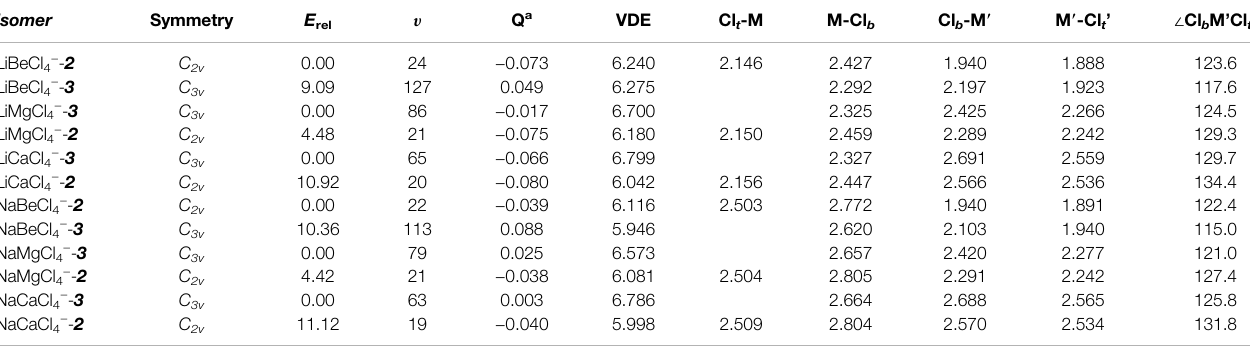
TABLE 1 | Relative energies E rel (kcal/mol), the lowest vibrational frequencies υ (cm − 1 ), total NBO charges on the MCl subunit (|e|), vertical detachment energies VDE (eV), bond lengths (Å), and select bond angles (degree) of the MM ′ Cl 4 − (M = Li, Na; M ′ = Be, Mg, Ca) anions. Isomer Symmetry